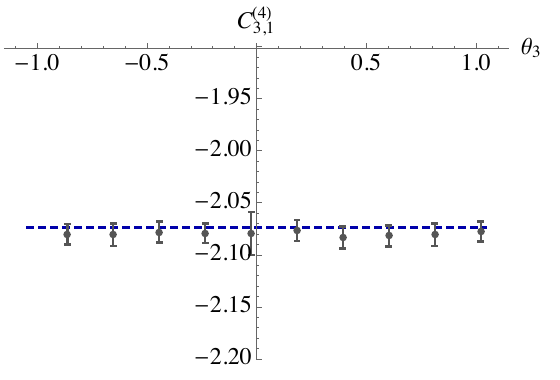
Figure 1 . Numerical estimate of C (4) and variable (cid:18) 3 with j (cid:18) 3 j < (cid:25)